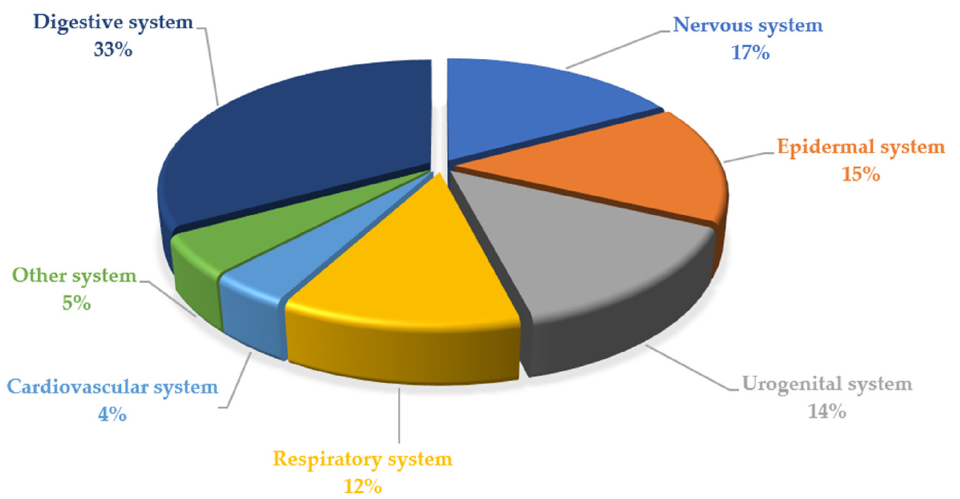
Figure 4. Folk therapeutical uses (percentage).